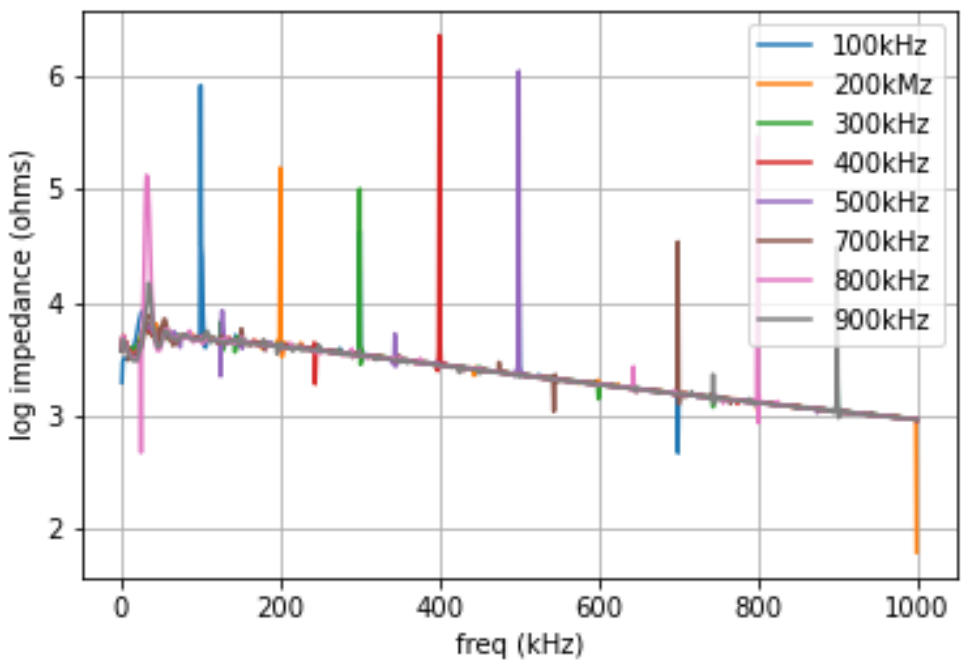
Figure A2. Resolved sub-harmonics between 1 kHz and 1 MHz. Because this plot includes finer-scale resolution, we did not run the 10 MHz scan.